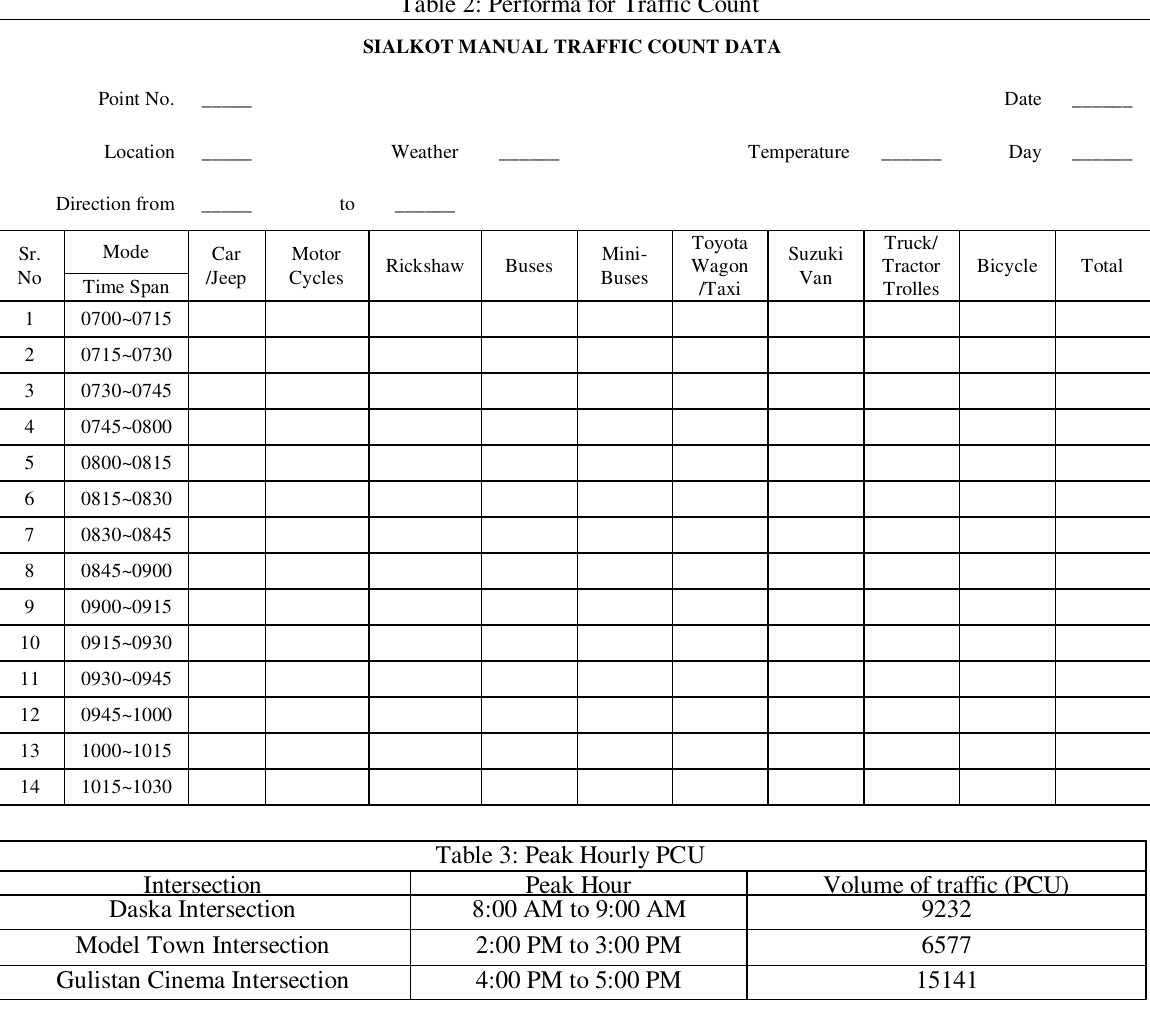
Table 2: Performa for Traffic Count SIALKOT MANUAL TRAFFIC COUNT DATA